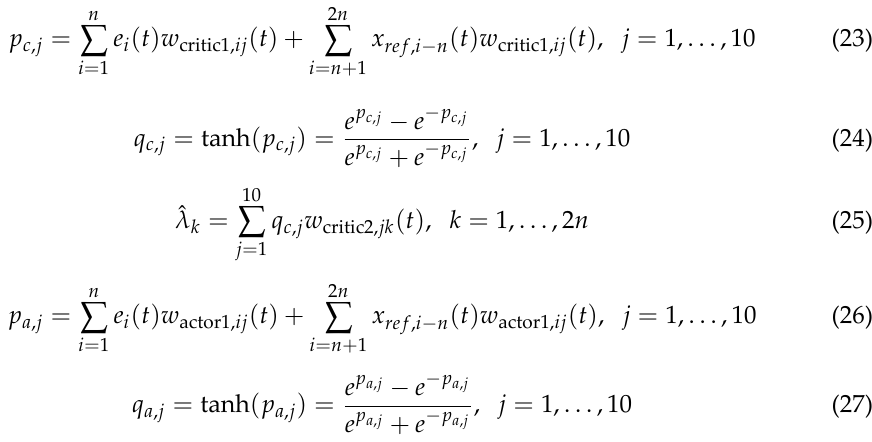
− ( 1 )) λ X t and the augmented state are required to be stored and used in up- dating the NNs, without predicted ones. The control policy estimated by the actor NN is updated by minimizing the value function. A two-layer neural network with one hidden layer containing 10 neurons is used as the critic NN and actor NN in this article, shown in Figure 3. The hidden-layer activation function is tanh. For the critic NN, , and represent the weights from the i th input node to the j th hidden layer node and the j th hidden node to the k th output node, respectively. For the actor NN, , and represent the weights from the i th input node to the j th hidden layer node and the j th hidden node to the k th output node. The intermediate variables for the j th hidden layer node and the outputs of the neural networks can be written as: